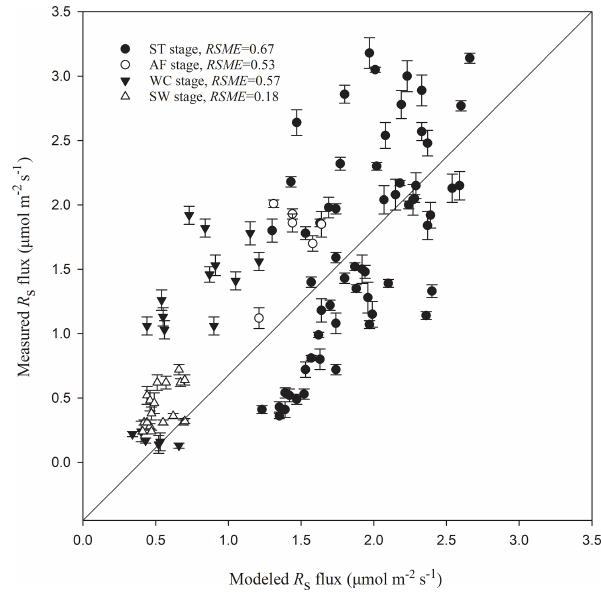
Figure 5. Modeled vs. measured R s fluxes at different freeze–thaw stages. Error bars represent standard errors in measured R s flux ( n = 6). The solid line is a 1:1